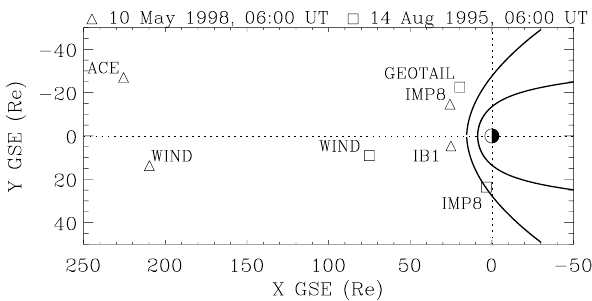
Fig. 1. The ISTP spacecraft positions in GSE